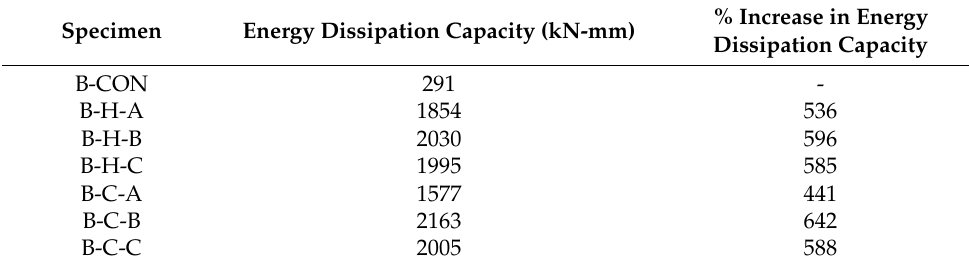
Table 7. Energy dissipation capacity of control and FRRP strengthened RC beams.